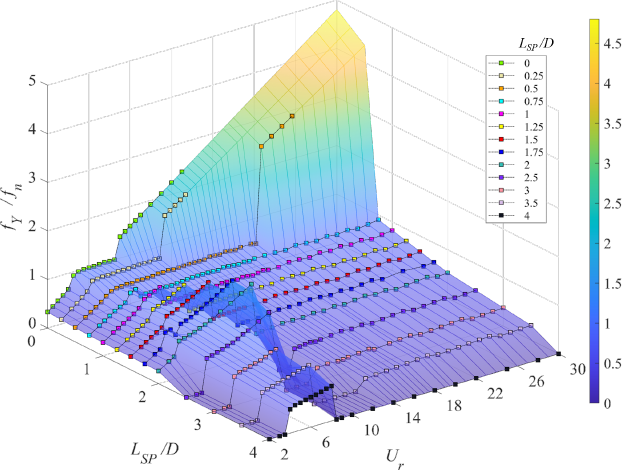
Figure 9. The dominant vibration frequency normalized by structural natural frequency ( f ∗ plotted as a function of the plate length L SP and the reduced velocity U r